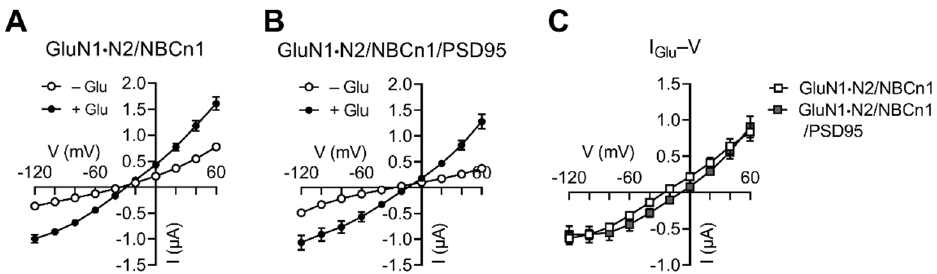
Figure 4. PSD95 has negligible effect on I Glu in the presence of NBCn1. ( A ) I–V relationships of glutamate-evoked responses by GluN1 · N2/NBCn1 ( n = 11). ( B ) I–V relationships of glutamate- evoked responses by GluN1 · N2/PSD95/NBCn1 ( n = 7). ( C ) I Glu –V relationships. I Glu is the mean difference before and after glutamate application in ( A , B ).